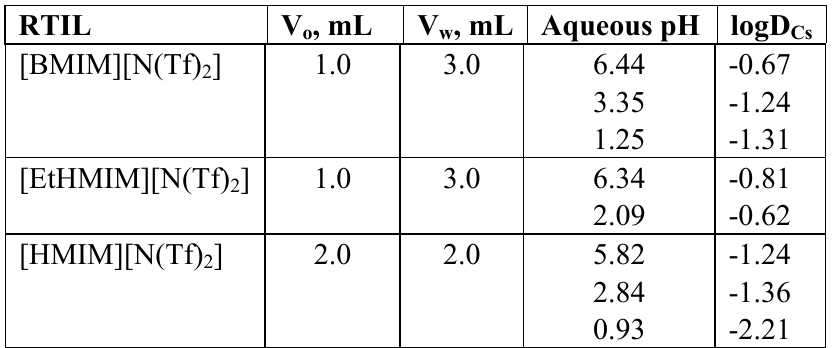
Table 2. Distribution ratios of cesium [C w0 (Cs) = 1.5 × 10 -3 mol·dm -3 ] and 18C6 [C o0 (18C6) = 1.5 × 10 -1 mol·dm -3 ] in the presence of each other between RTIL/aqueous phases as a function of pH at 22 °C (V